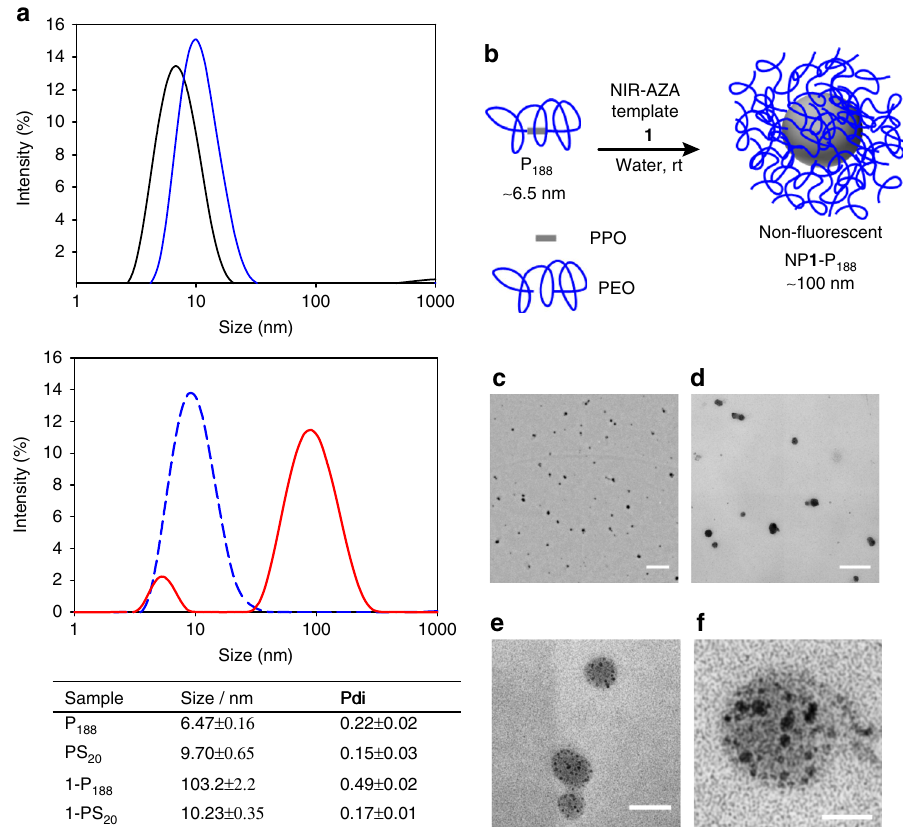
Fig. 3 Directed self-assembly (DSA) of nanoparticles from P 188 and 1 . a Dynamic light-scattering (DLS) properties of P 188 and PS 20 with and without 1 (average of three independent experiments). DLS traces for; P 188 (solid black); PS 20 (solid blue), NP 1 -P 188 (solid red), 1 -PS 20 (dashed blue). Measurements taken at 25 °C, conc: 5 µ M 1 ; 1.19 mM P 188 ; 8.14 mM PS 20 (Pdi polydispersity index). b Schematic for DSA of 1 doped P 188 nanoparticles with an outer poly (ethylene oxide) (PEO) (blue) and inner poly(propylene oxide) (PPO) (grey) shells. c – f Transmission electron microscopy (TEM) images of NP 1 -P 188 at low and high magni fi cations with scale bars at 500, 200, 50 and 20 nm